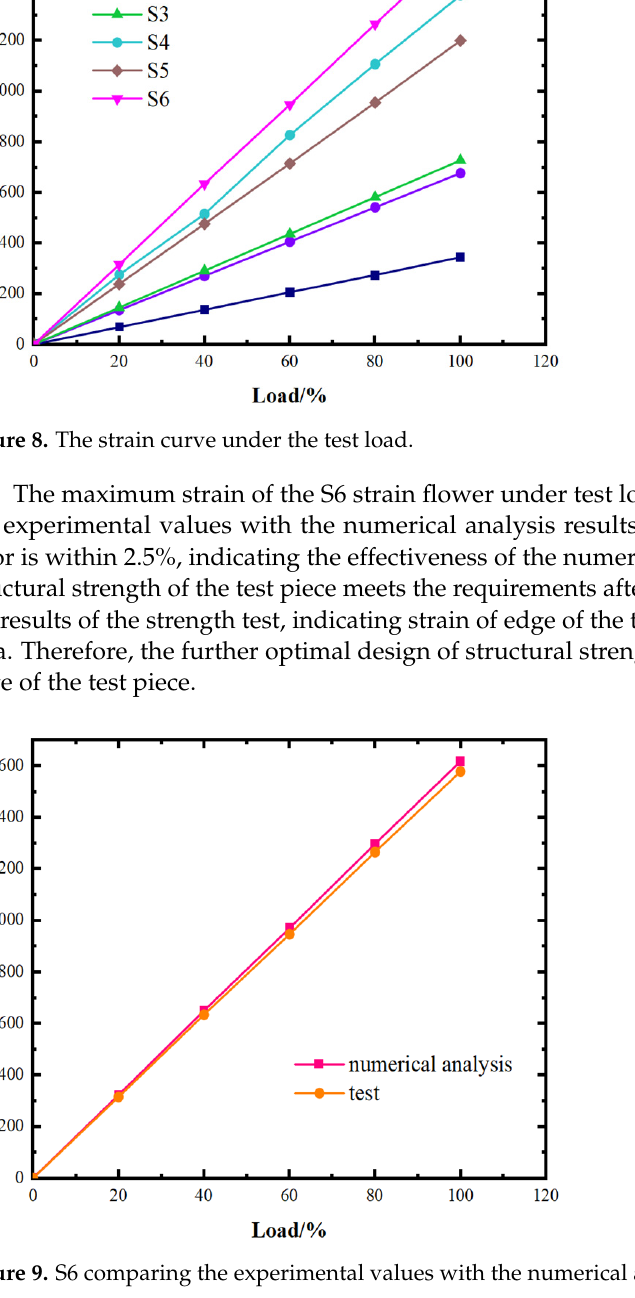
Figure 9. S6 comparing the experimental values with the numerical analysis results.